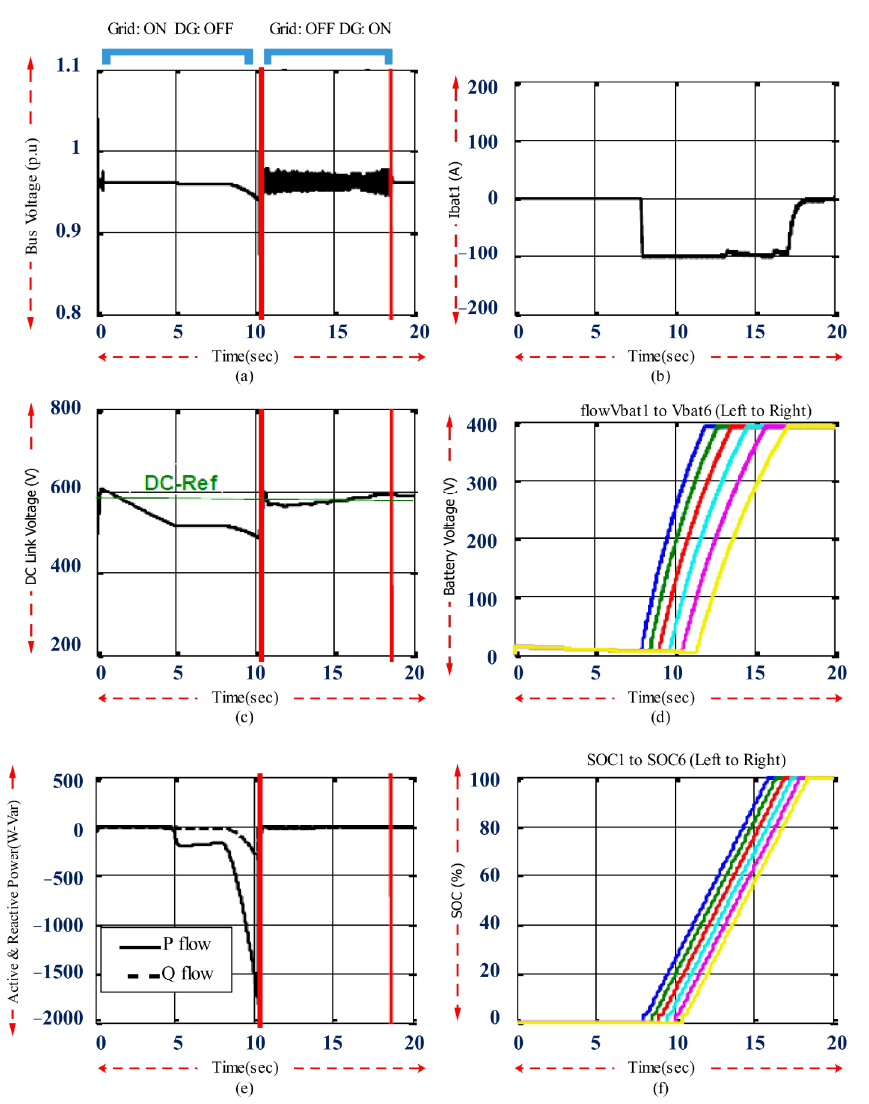
Figure 21. The results of fast charging of EVs in the microgrid in the state of connection to the grid and selected diesel ( a ) network bus voltage; ( b ) exchange of active and reactive power of the net- work bus with the EV system; ( c ) DC link voltage; ( d ) battery current; ( e ) voltage of batteries; ( f ) SOC.